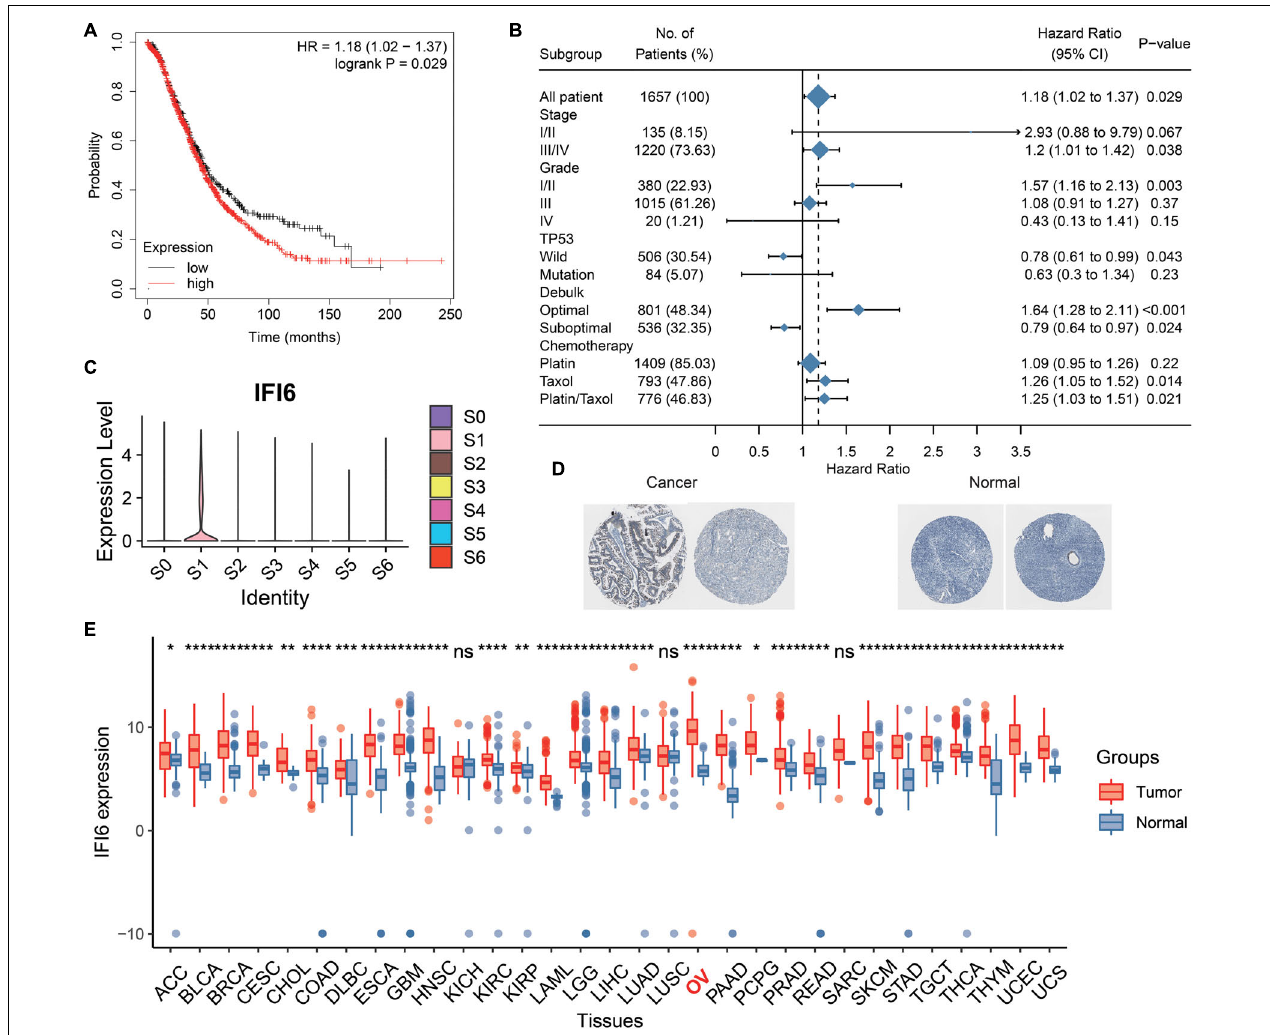
FIGURE 5 | Analysis of prognosis and expression level of IFI6 in OC. (A) Kaplan–Meier curve illustrating higher IFI6 accompanied by poor OS. (B) Survival associated with IFI6 in different subgroups of OC patients. (C) IFI6 has a high expression in S1. (D) Representative protein expression levels of IFI6 were high in OCs based on the Human Protein Atlas database. (E) Box plot showing higher IFI6 in OCs than paired normal